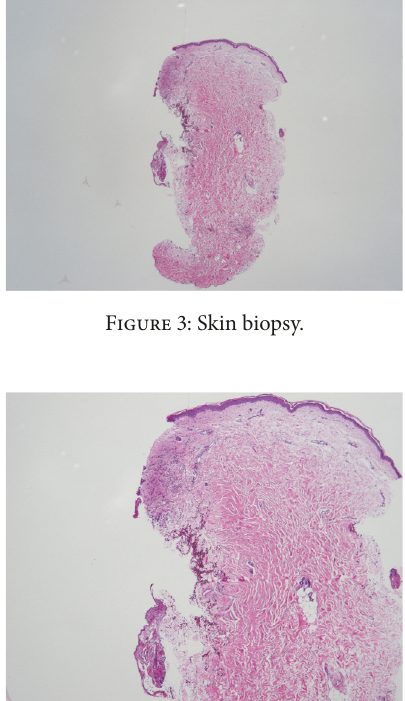
Figure 2: Crusted vesicle.